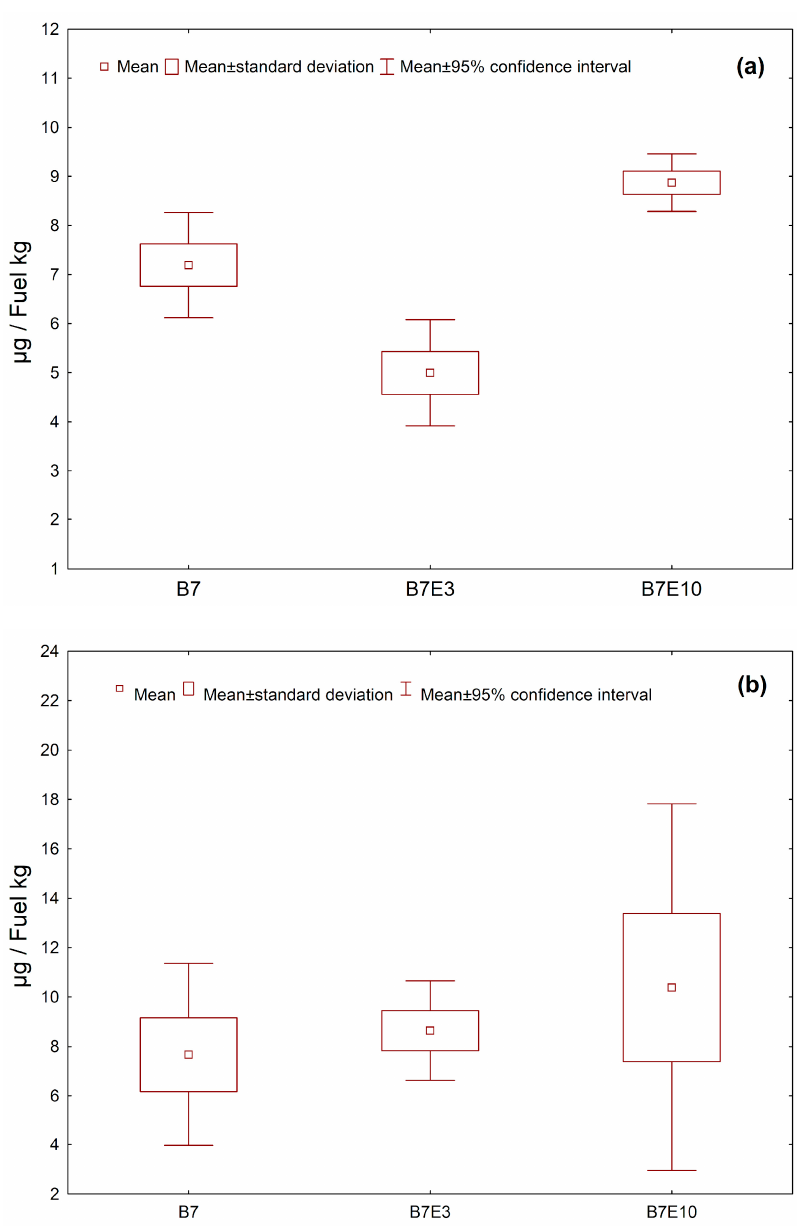
Figure 3. ( a ) PM 1.0 emission factor for B7, B7E3 and B7E10 fuel blends; ( b ) PM 2.5 emission factor for B7, B7E3 and B7E10 fuel blends.